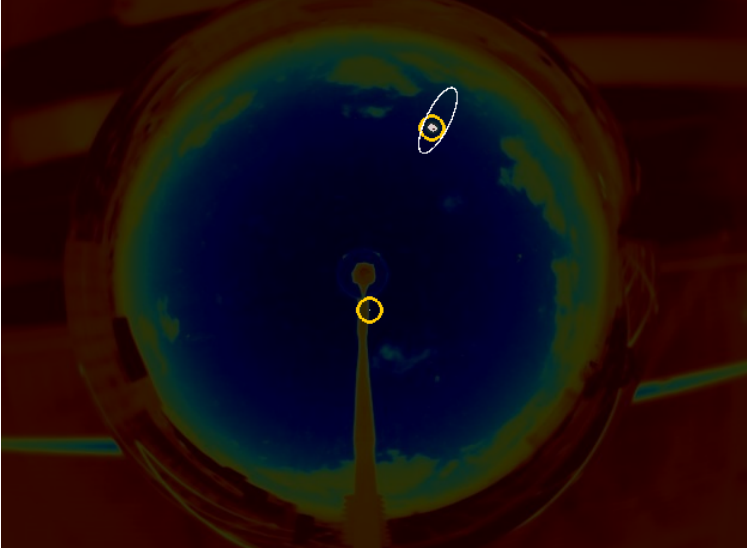
Figure 10. Reduction of the space for the Sun